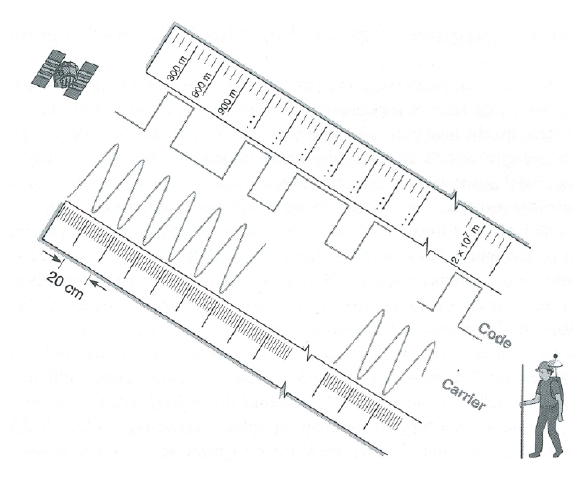
Figure 2: Conceptual representation of code and carrier phase mea- surements with a measuring tape (Misra and Enge, 2011)